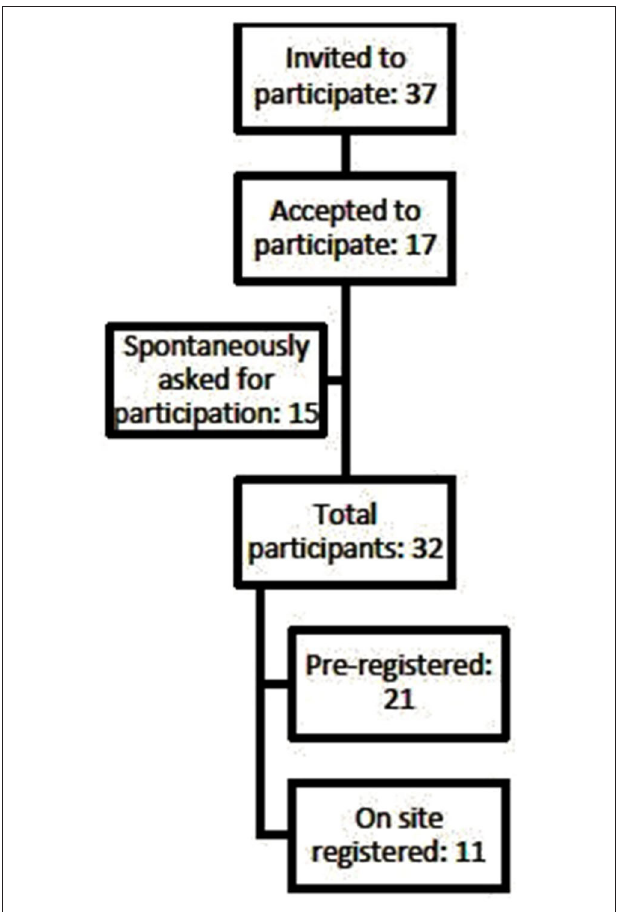
FIGURE 2 | Recruitment process of participants in the